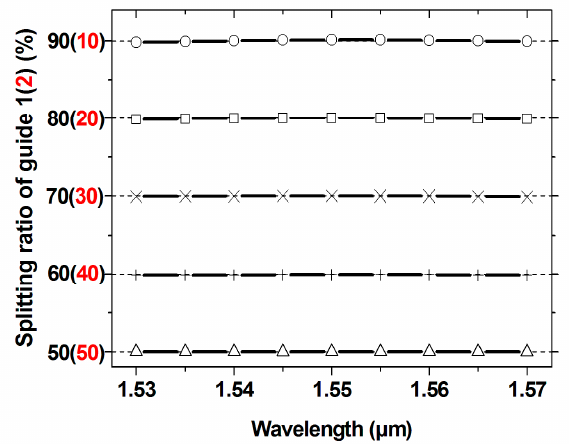
Figure 4. Five specific splitting ratios of output port guide 1 and guide 2 as the function of wavelength for each specific shifting lengths L s .